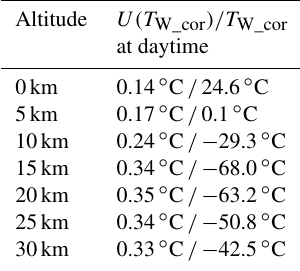
Table 5. U(T W_cor ) of DTR ( k = 2) at daytime. Altitude U(T W_cor )/T W_cor at daytime